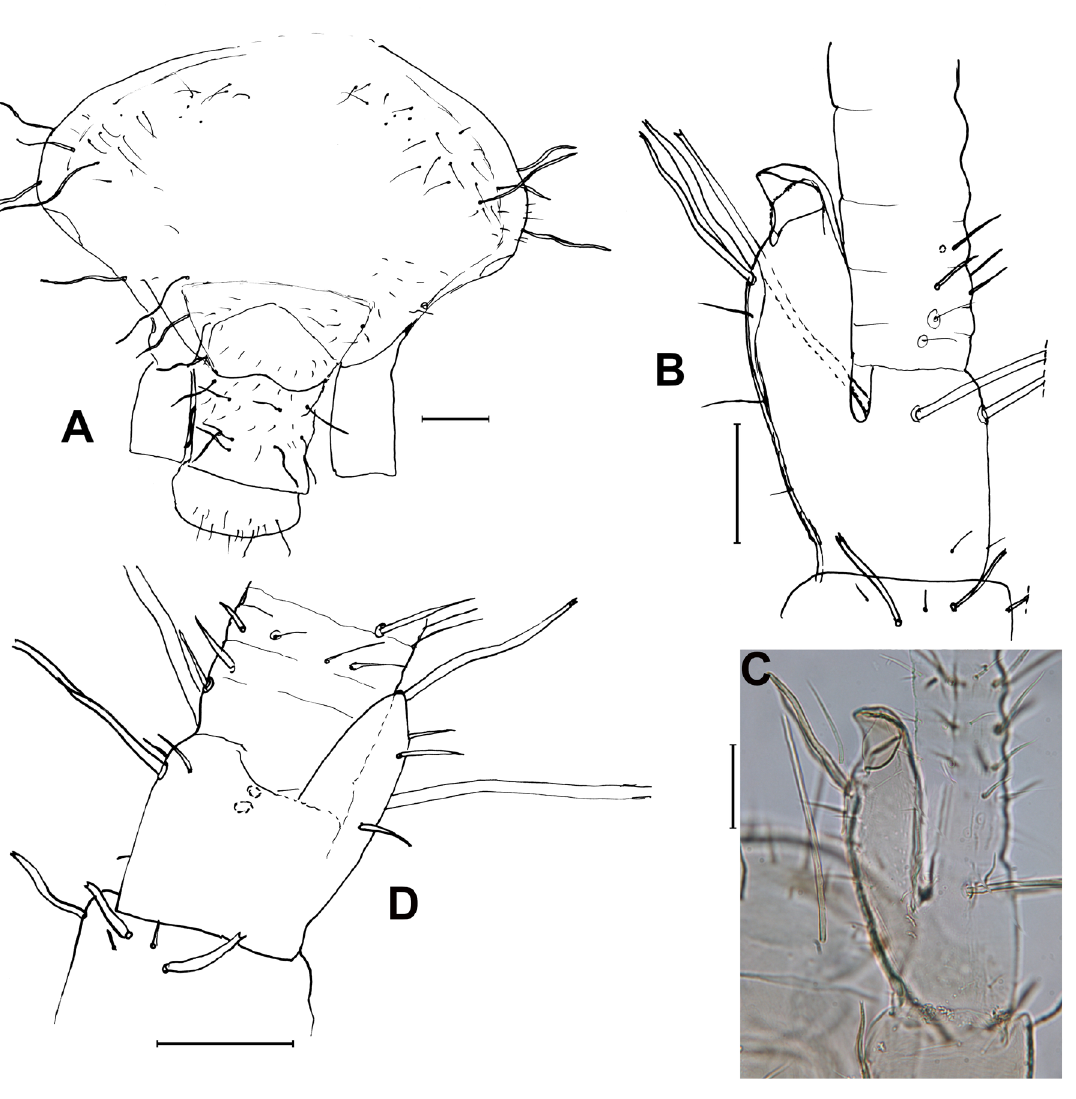
Fig. 6. Coletinia dextra Molero-Baltanás, Bach de Roca & Gaju-Ricart sp. nov. Holotype, ♂ (MNCN_ Ent 283557). A . Head. B . Right antenna: pedicel with apophysis and basal annuli of the flagellum. C . Idem, micrograph. D . Left antenna: pedicel with apophysis and basal annuli of the flagellum. Scale bars: A = 0.2 mm; B–D = 0.1